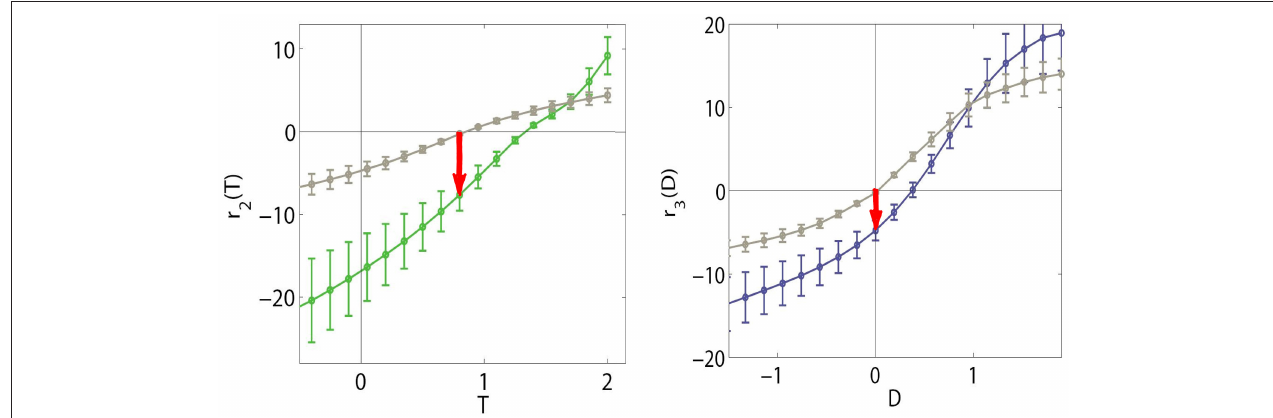
FIGURE 10 | Shifts in the nonlinear response of SPCA color sensors when adapted to biased image statistics. When adapted to the biased environment, the responses of the sensors identified by our method (RG in green on the left and YB in blue on the right) shift with regard to the curves in gray (adaptation to a diverse environment, large D65 database and stimulation along the black lines in Figure 9 ). Note that in this case, a stimulus eliciting zero responses (perceived as white) in the diverse environment situation, would elicit negative responses in the RG and YB mechanisms (red arrows) in the restricted